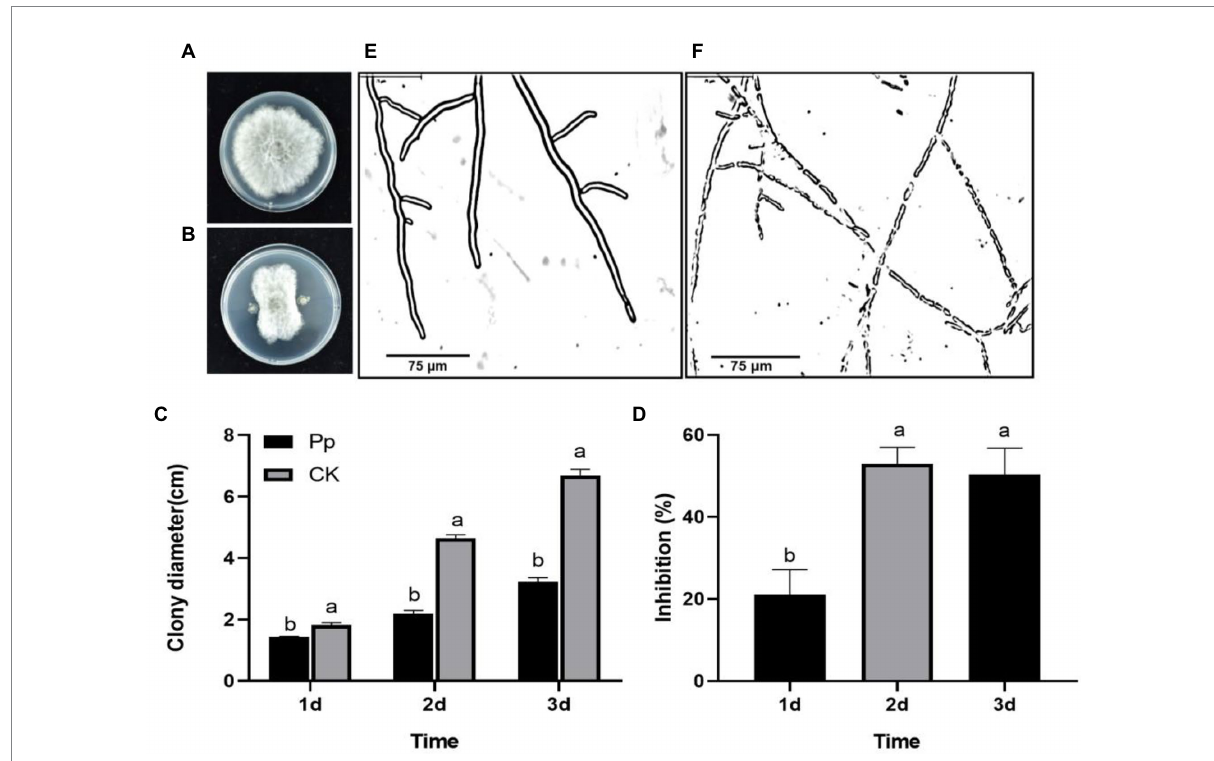
FIGURE 1 The suppression of Pseudomonas protegens on the mycelia growth of Botryosphaeria dothidea on the PDA medium. The untreated control mycelia (A) and the P. protegens- treated mycelia (B) that were incubated on the PDA medium for 3 days. The comparison of the colony diameter of the different treatments (C) . P. protegens significantly inhibited the mycelial growth of the fungus B. dothidea (D) . Compared to the control (E) , the P. protegens severely damaged the mycelial morphology of B. dothidea (F) . Lowercase letters indicate a significant difference between treatments ( p <